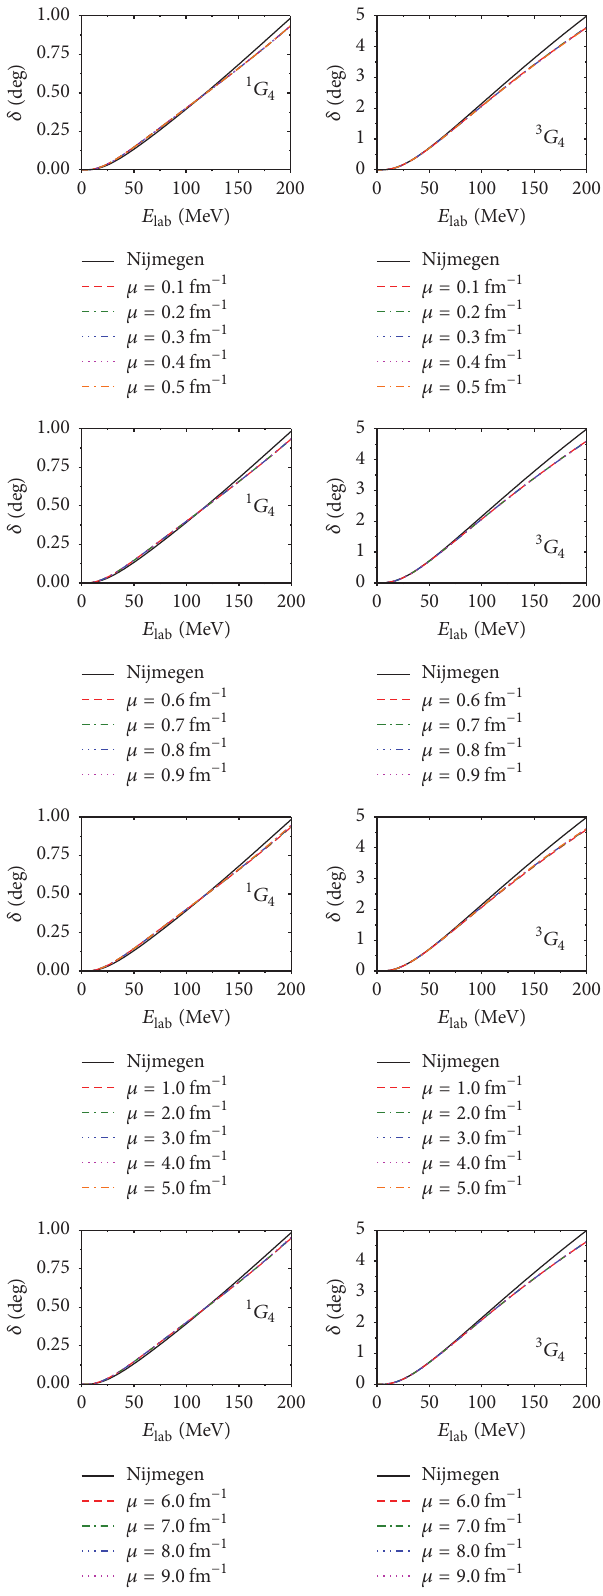
Figure 2: (Color on-line) phase shifts in 1 𝐺 4 and 3 𝐺 4 uncoupled channels calculated from the solution of the subtracted LS equation for the 𝐾 -matrix with five subtractions for the N3LO-EM potential for several values of the renormalization scale compared to the Nijmegen partial wave